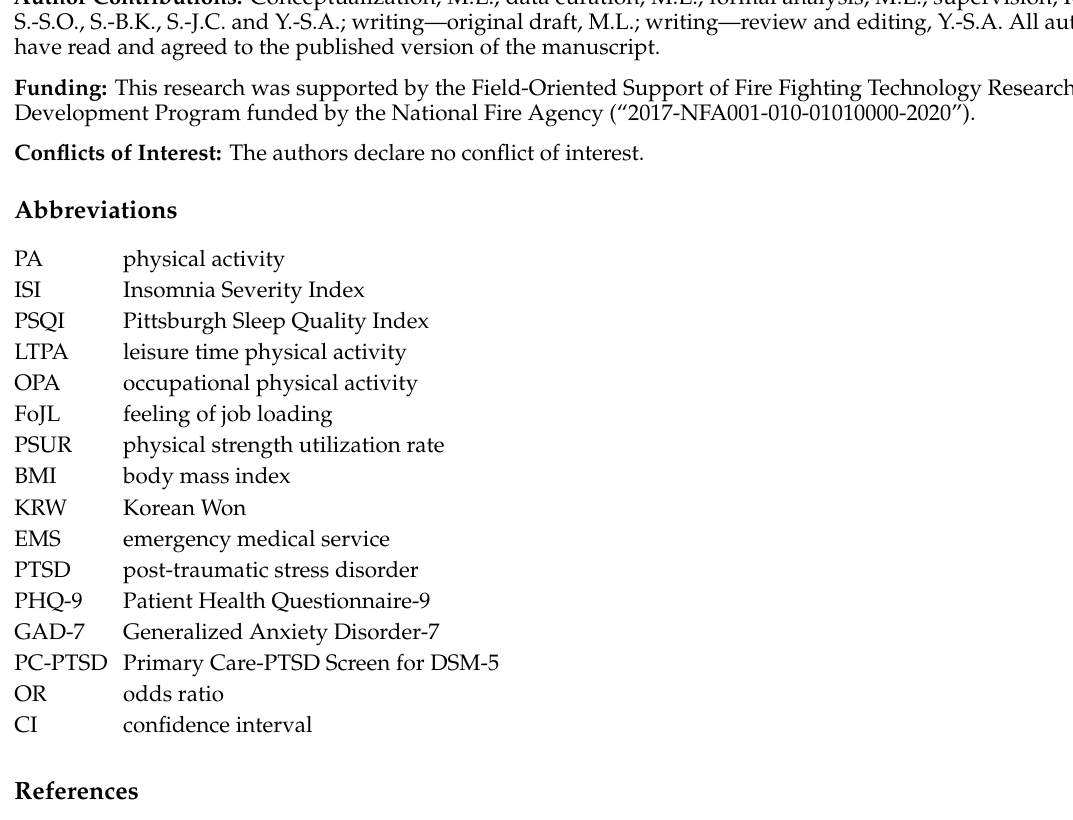
Table S1: Association between leisure time physical activity (LTPA) and insomnia according to subjective occupational physical activity (subjective OPA) in the group without psychological symptoms (n = 8578), Table S2: Association between leisure time physical activity (LTPA) and insomnia according to objective occupational physical activity (objective OPA) in the group without psychological